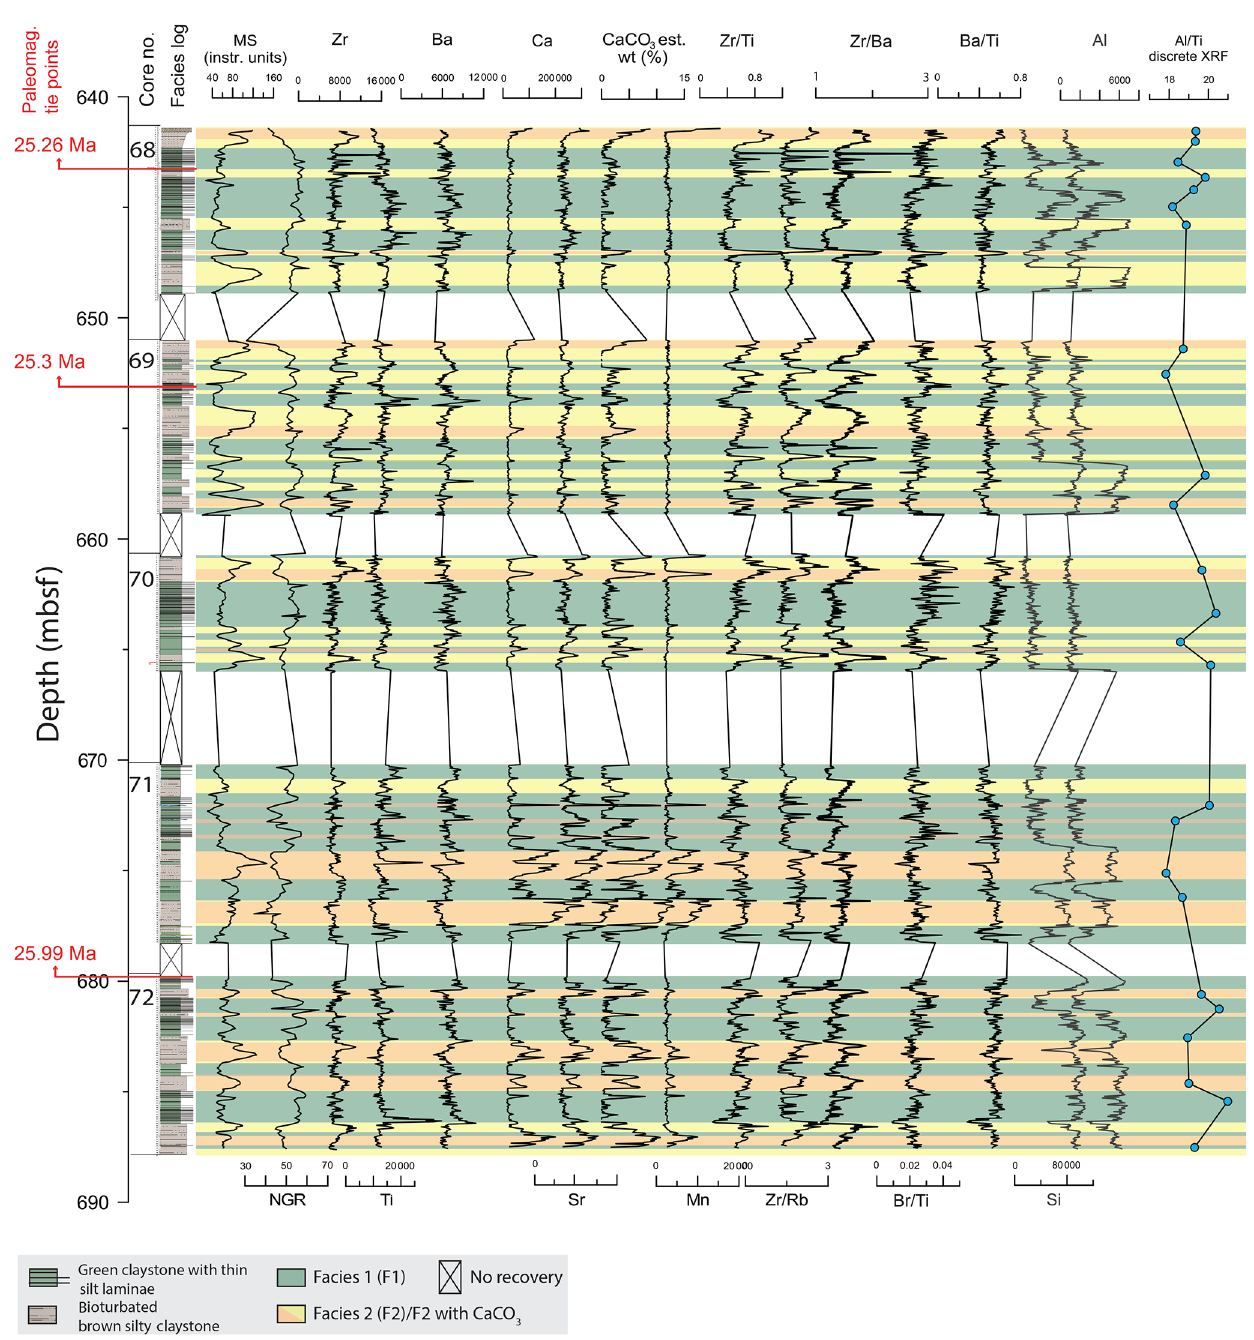
Figure 2. Magnetic susceptibility (MS) and natural gamma radiation (NGR) physical properties and selected X-ray fluorescence (XRF) data (in total counts) and elemental ratios plotted against the new detailed U1356 facies log between 689.4 and